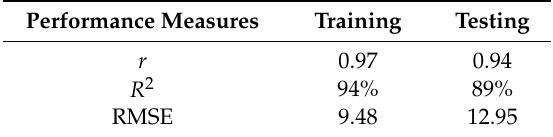
Table 4. Performance measures that determined the accuracy of the developed model.